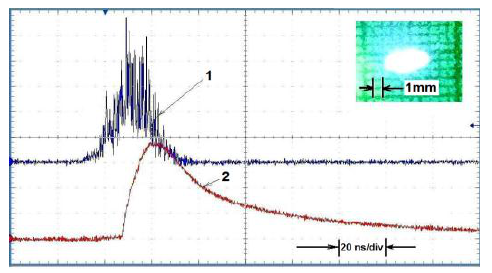
Fig. 1. Intensity of the laser pulse and induced from them spark in time domain, and the photo of the laser induced spark.